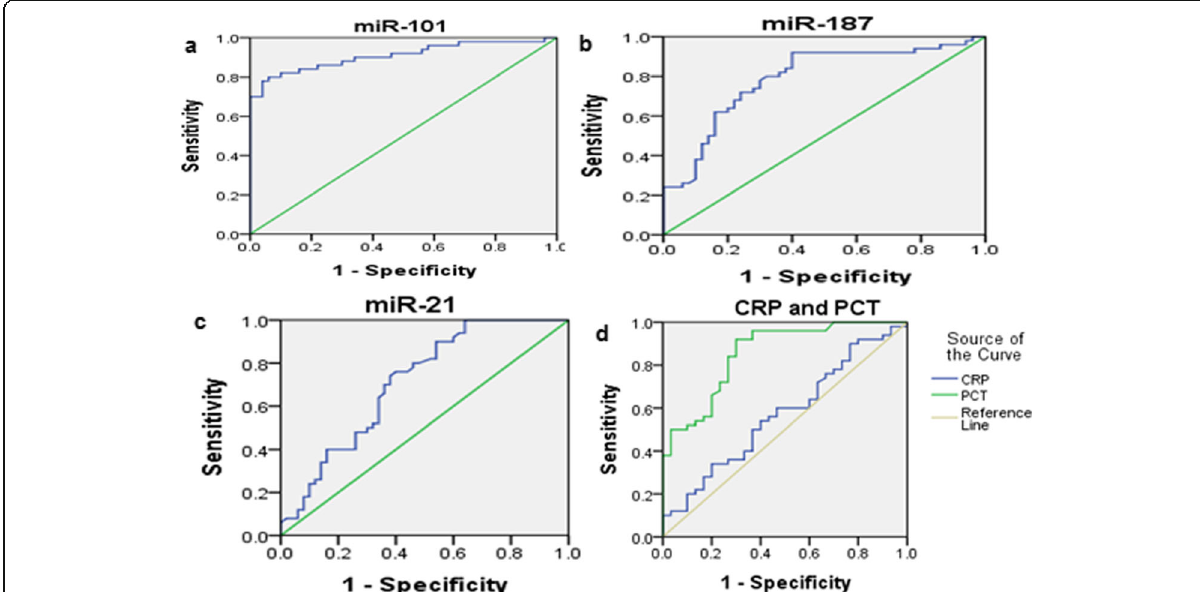
Fig. 2 ROC analyses of miRNAs 101, 187, and 21 normalized expression levels (2 −Δ Ct ) and the clinical indicators for discrimination between sepsis and SIRS groups